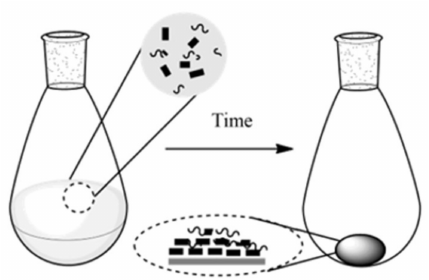
Figure 4. Scheme representation of synthesis of nanocarbon/polymer nanocomposite using self- assembly